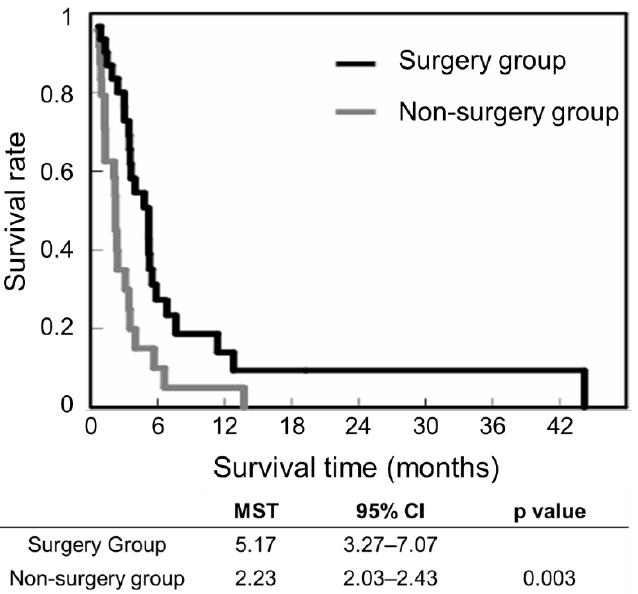
Figure 5. Kaplan–Meier survival rate; CI: confidence interval; MST: median survival Figure 5. Kaplan – Meier survival rate; CI: confidence interval; MST: median survival time.